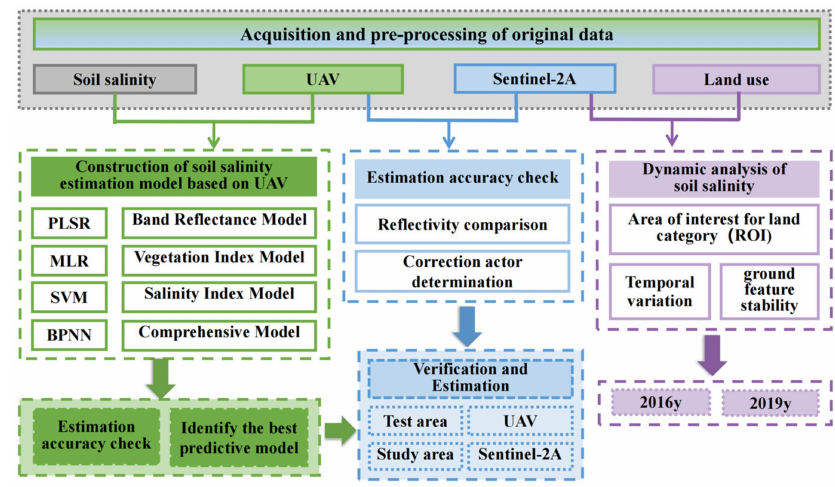
Figure 2. Methodological scheme of this